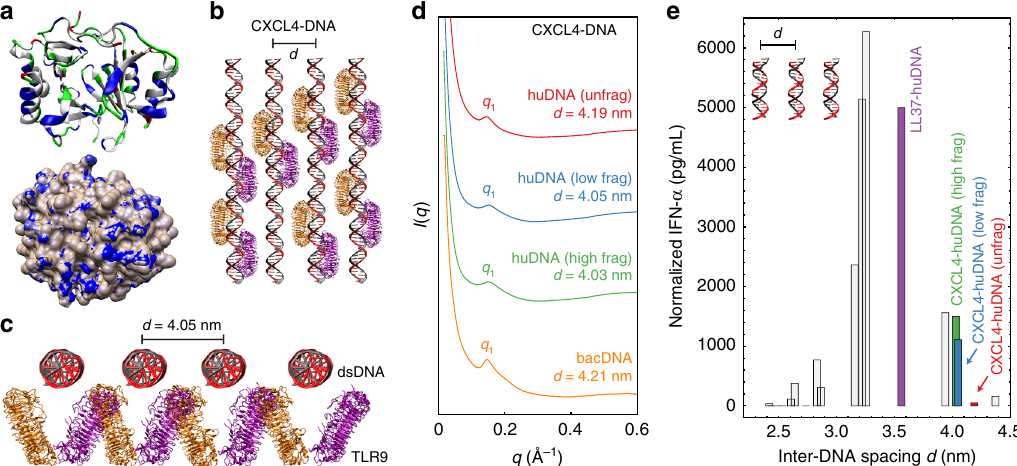
Fig. 6 CXCL4 organizes both self-DNA and bacDNA into liquid-crystalline supramolecular complexes at an inter-DNA spacing that facilitates ampli fi ed TLR9 activation. a Structure of CXCL4 (PDB ID: 1F9Q) with solvent-exposed putative DNA-binding cationic surface residues in blue and hydrophobic residues in white (top). Uncharged polar residues are shown in green and anionic residues are shown in red. Molecular structures were visualized in visual molecular dynamics (VMD). TLR9 structure (PDB ID: 3WPG) was obtained from previous work 28 . The electrostatic potential map of the CXCL4 surface was calculated in Chimera using the APBS plugin (bottom). Blue corresponds to a positive electrostatic potential and white corresponds to a neutral potential. b Graphical schematic to scale of ordered CXCL4 – DNA complexes binding to clustered TLR9. CXCL4 is omitted for clarity. Top – down view and c end-on view of CXCL4-fragmented huDNA complexes binding to TLR9 dimers (orange and purple). CXCL4 organizes huDNA (black – gray) into a liquid- crystalline columnar complex with an average inter-DNA spacing d = 4.05 nm, near the optimal value for intercalative multivalent binding to a clustered array of TLR9 receptors, consistent with elevated levels of IFN- ɑ production. d SAXS data of CXCL4 bound to huDNA and bacDNA: The fi rst peak positions q d ) are indicated. CXCL4 forms liquid-crystalline supramolecular complexes with huDNA and bacDNA, cognate to those formed 1 and inter-DNA spacings ( with LL37 but with a lower degree of DNA ordering (Supplementary Fig. 7). e Plot of TLR9 activation vs. inter-DNA spacing for CXCL4 – huDNA complexes. The fragmentation state of huDNA affects the ability of complexes to induce IFN- ɑ production from pDCs. Gray bars derived from previously published data 28 . Relative TLR9 activation levels are consistent with the relative levels of cytokine production predicted from the inter-DNA